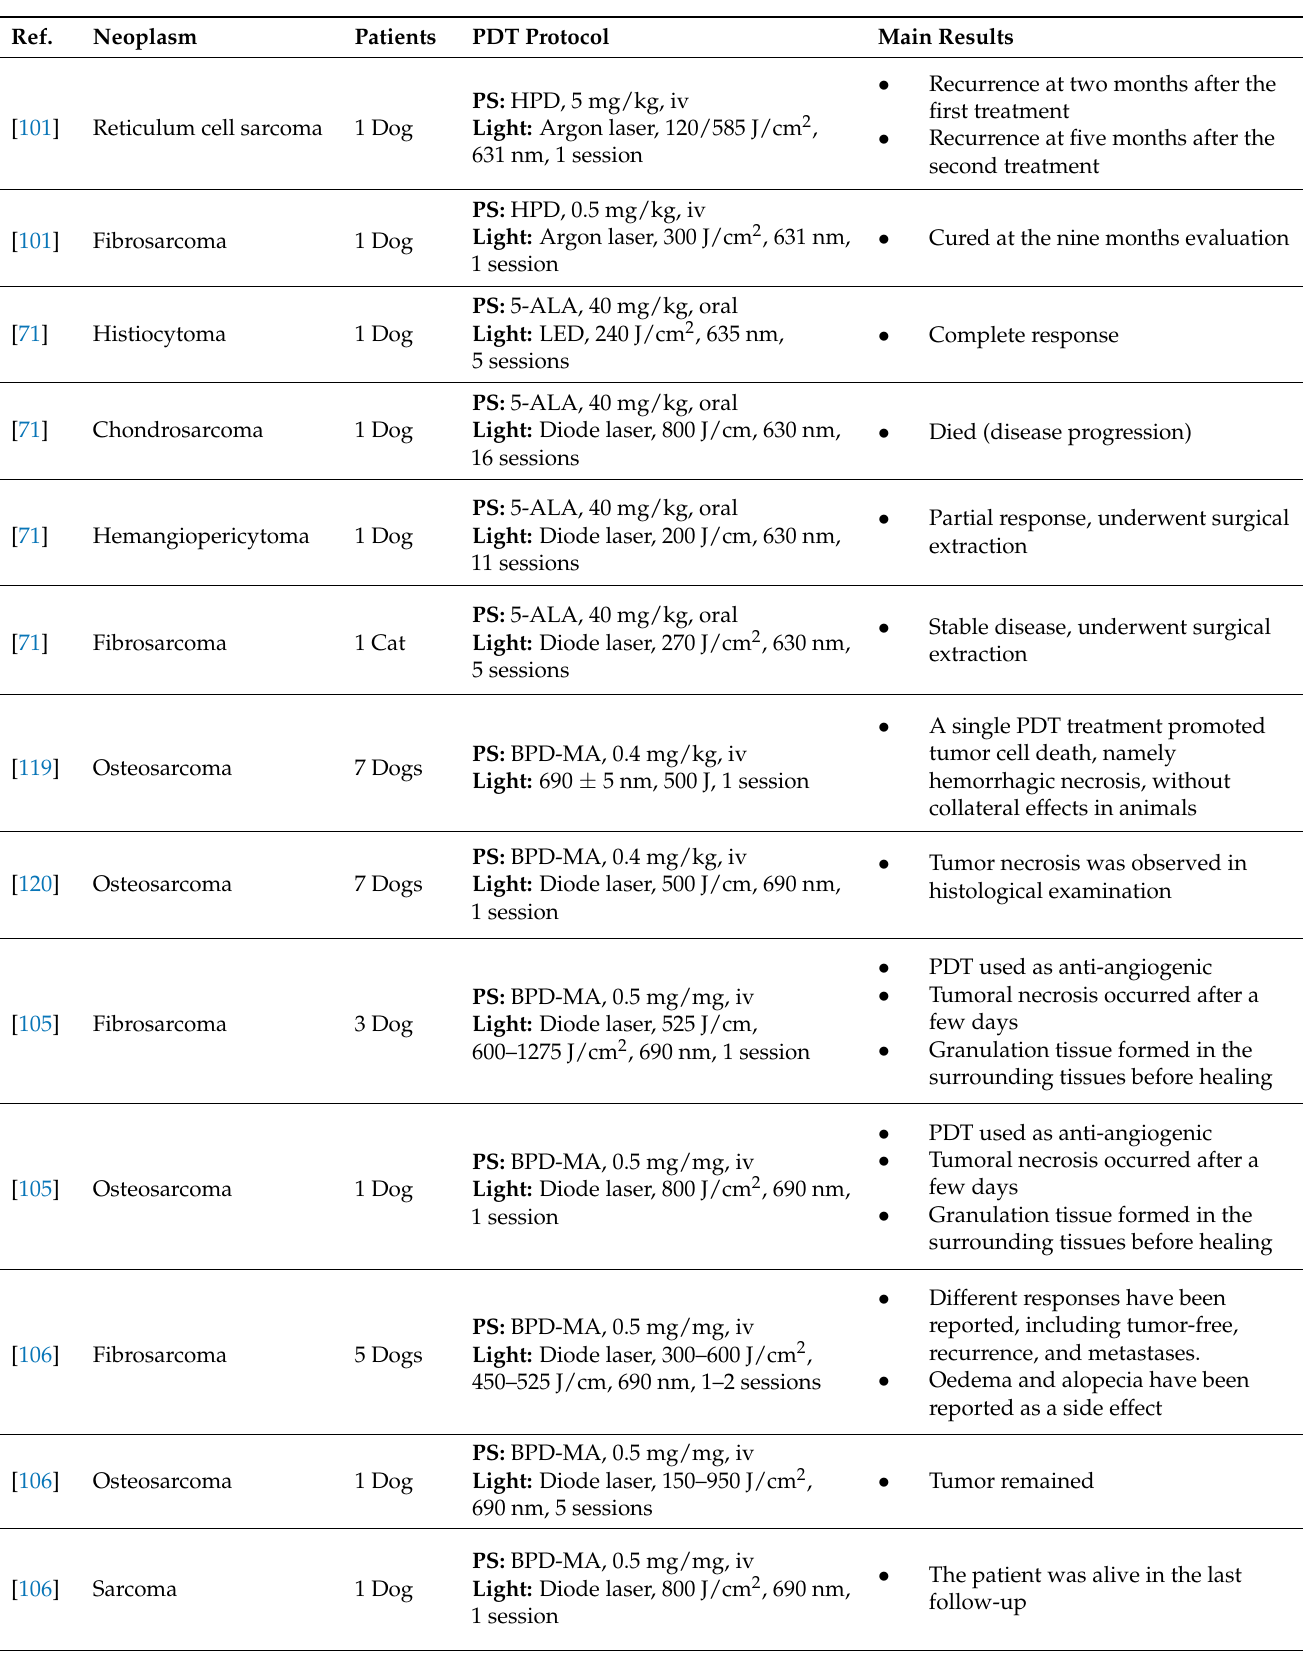
Table 3. Clinical studies on PDT in animals with